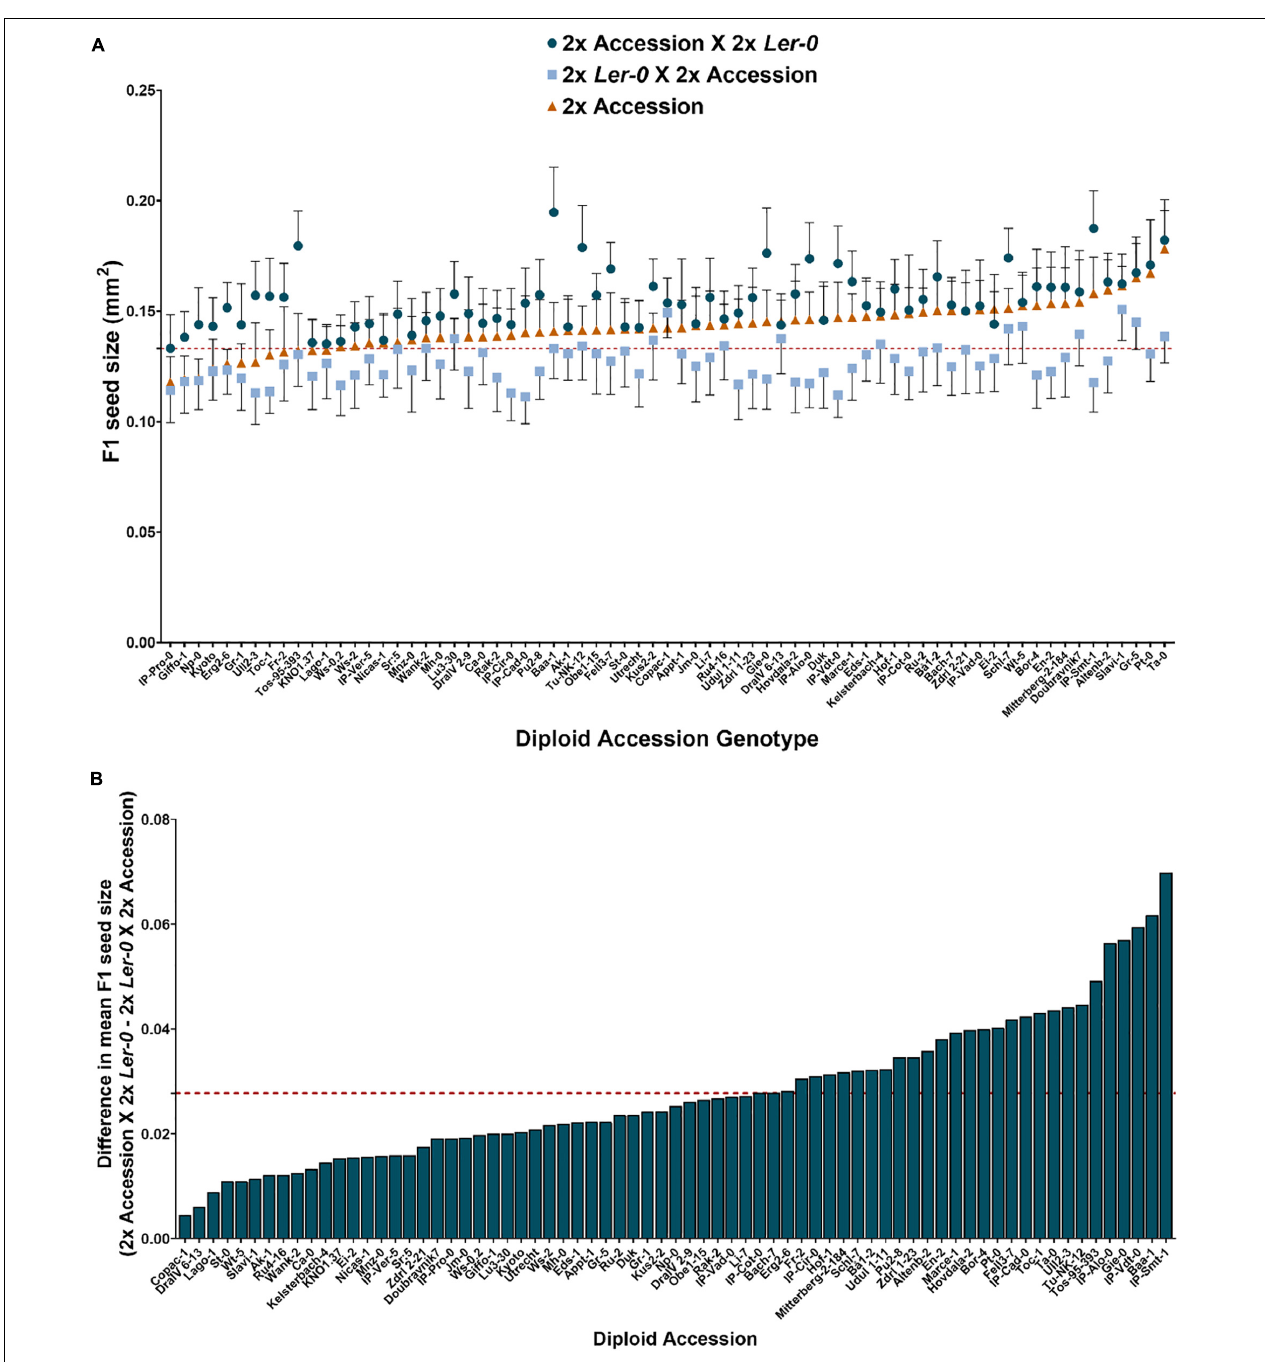
FIGURE 1 | Heterosis effects on F1 seed size observed in reciprocal F1 hybrid diploid seeds depends on parent-of-origin effects. (A) F1 hybrid diploid seed size of reciprocal crosses using 2x L er -0 as pollen donor (represented by blue circles) or as maternal parent (light blue squares). Seed size of selfed isogenic parental lines is also represented (orange triangles) for comparison with their reciprocal F1 offspring. The horizontal red dashed line corresponds to the mean seed size value of the accession 2x L er -0 (0.1332 mm 2 ). Error bars represent SD. N ≥ 40 seeds/genotype. (B) Natural variation for parent-of-origin effects on seed size across 71 reciprocal F1 hybrid diploids. The red dashed line represents the average difference in mean F1 seed area for the entire set of 71 reciprocal hybrids.